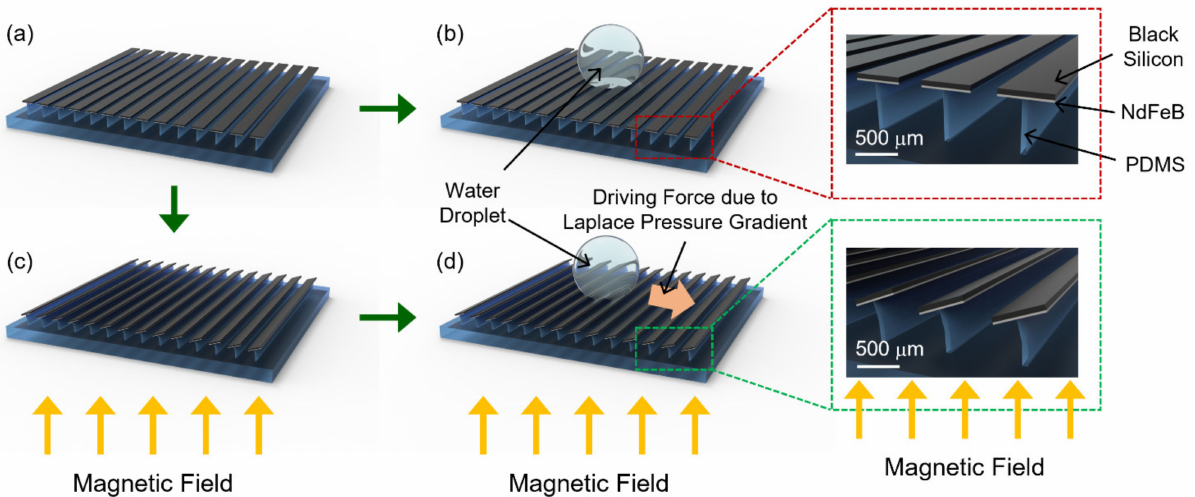
Figure 1. Illustrations of the magnetically actuated superhydrophobic black silicon strip array on an elastomer ridge array. ( a , b ) These illustrations show where no external magnetic field exists and thus no driving force is applied to a dispensed water droplet. ( c , d ) These illustrations show where an external magnetic field is applied, the strips are tilted, and a dispensed water droplet experiences a Laplace pressure gradient-induced driving